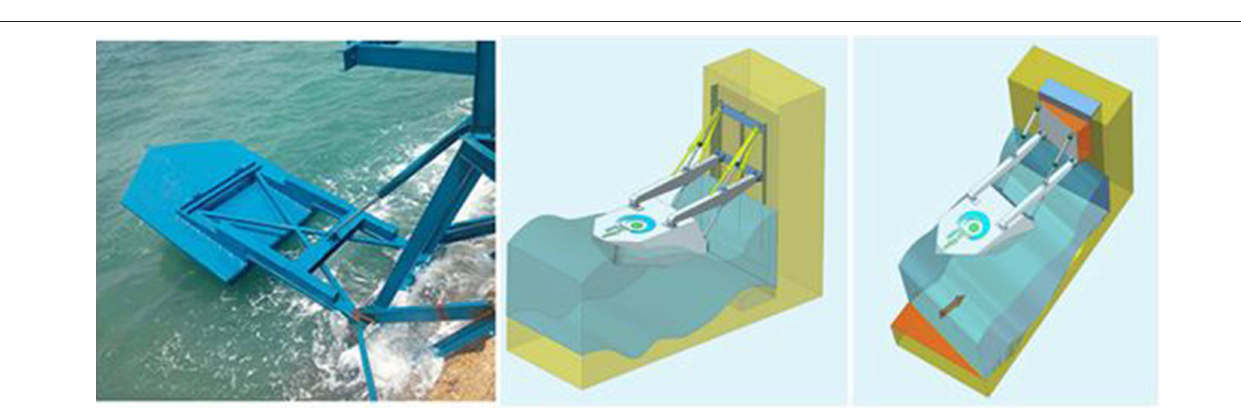
FIGURE 11 | EWP device (Left) and schematic representation of EWP Convertor (Right)